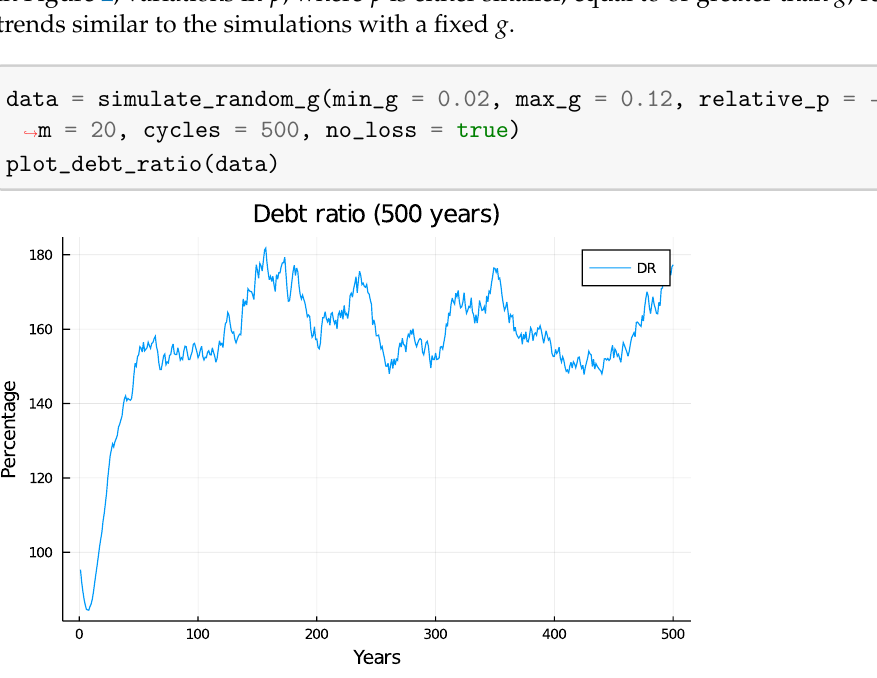
Figure 22. Debt ratio (2% <= g <= 12%, p = g -